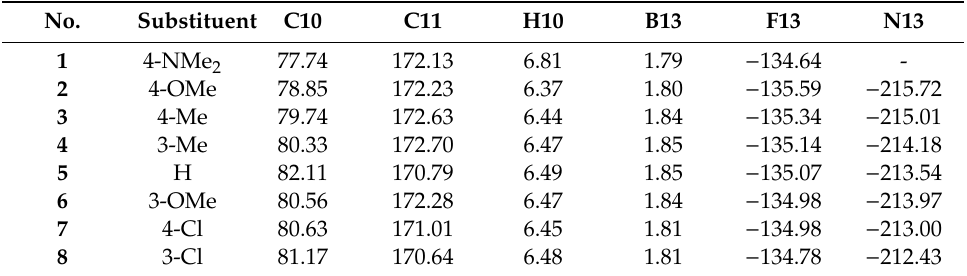
Selected 1 H, 11 B, 13 C, 15 N and 19 F-NMR chemical shifts of 2-phenacylbenzoxazole